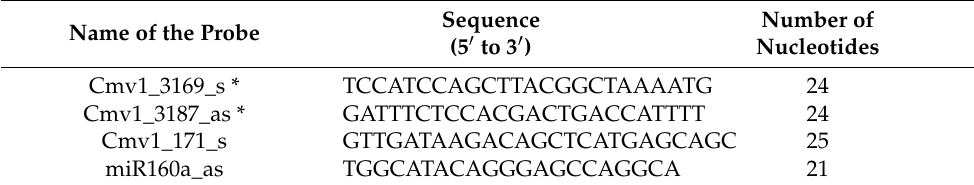
Table 3. DNA probes used for RNA blot